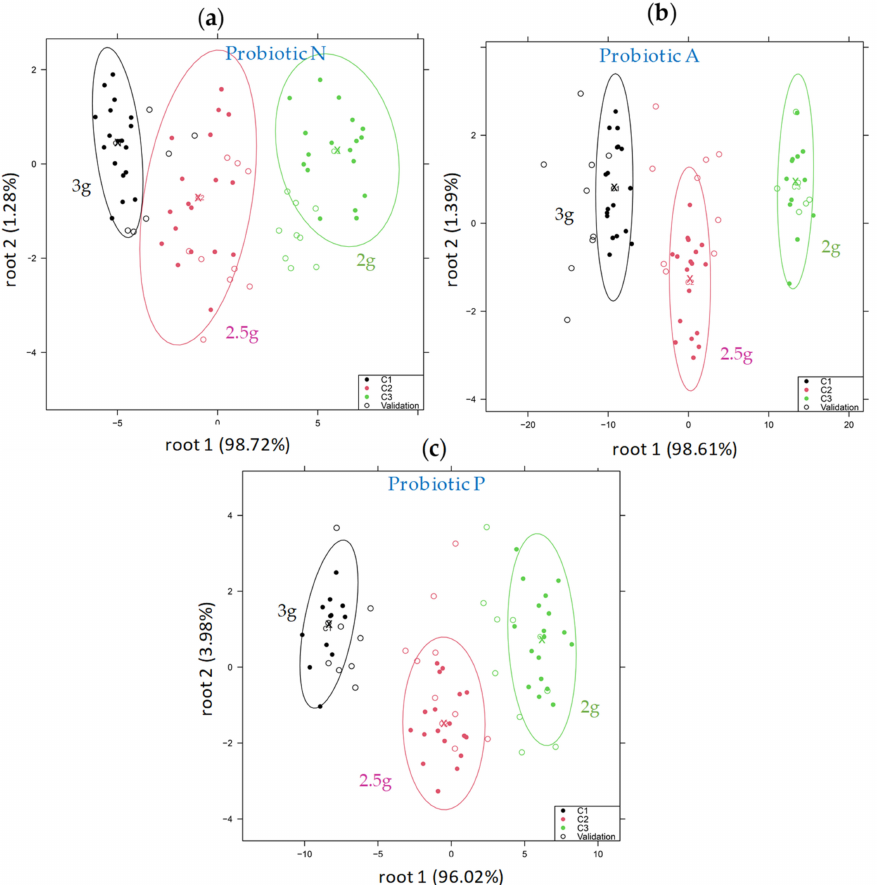
Figure 4. PCA-LDA for probiotic samples subjected to 90 ◦ C (T3) according to the concentration level for each probiotic type ( a ) probiotic N, ( b ) probiotic A, and ( c ) probiotic P. Built with 95% confidence interval ellipsis. The center of the ellipses is denoted by x, training and validation sets are denoted by solid and hollow points, respectively. N = 78 for probiotic N, N = 72 for probiotic A, and N = 75 for probiotic P. Table 1. Confusion table of the PCA-LDA models for probiotic samples subjected to 90 ◦ C (T3) according to the concentration